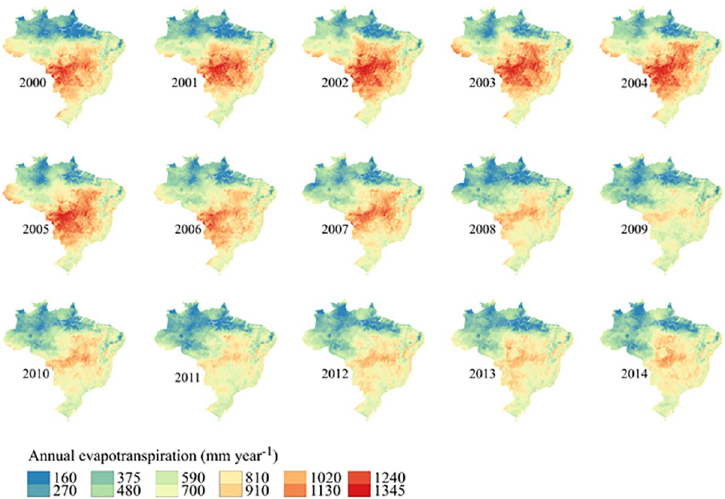
Fig 7. Difference between the annual values of MOD16 ETP and ETo obtained by the Cubist model over the 15 years. The figure was elaborated with the TIFF files processed in the paper, and using the free software QGIS [35].